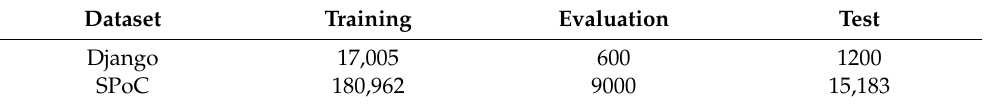
Table 2. The number of training, evaluation, and test samples in Django and SPoC datasets. Dataset